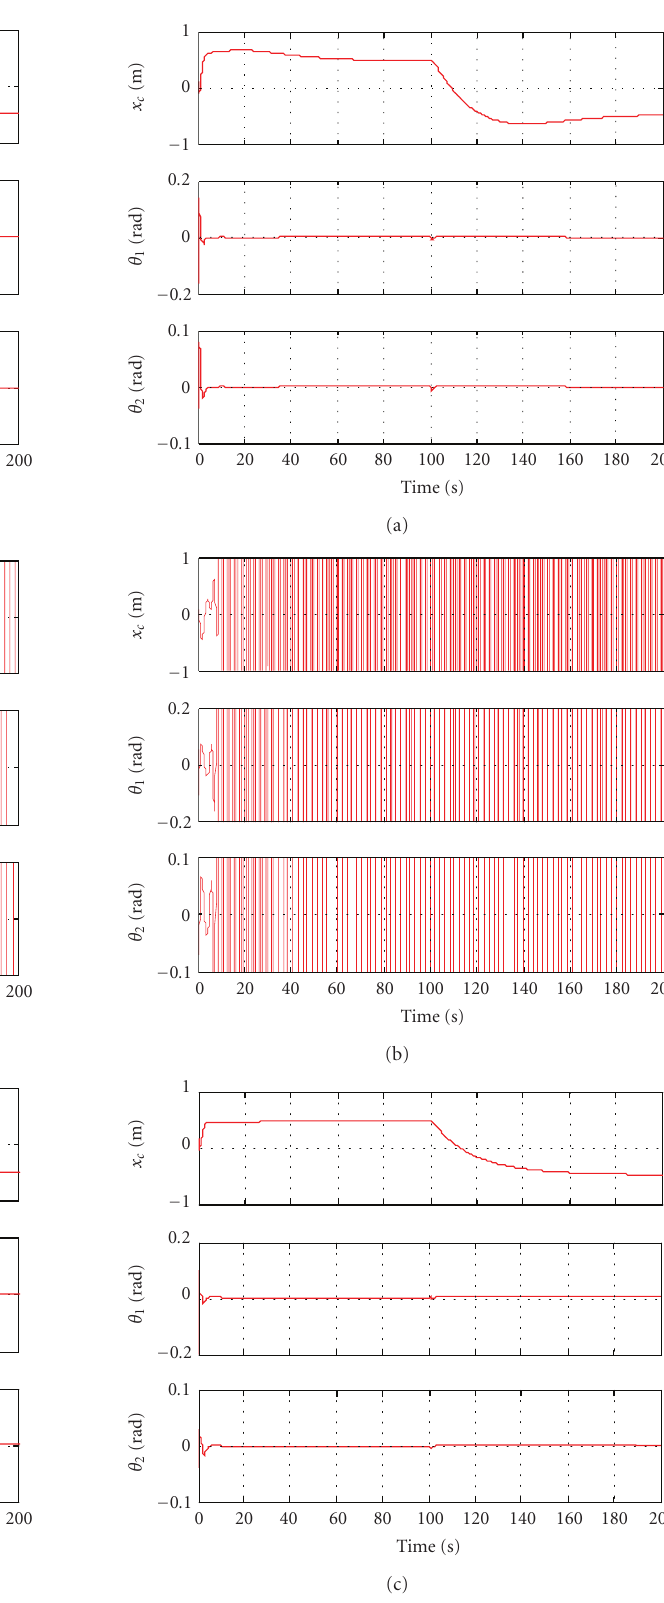
Figure 9: System responses of all controllers under multiple sensor fault condition, without modelling uncertainty. (a) —- FTCS, (b) ... H ∞ controller, and (c) - - - μ controller.